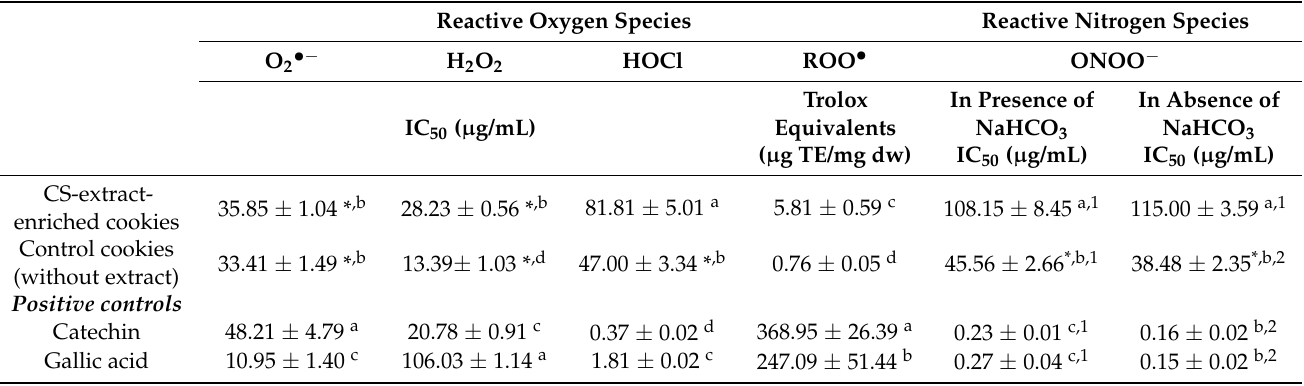
Table 4. Counteracting capacity of functional cookies enriched with chestnut shells extract and control cookies (without extract) against reactive oxygen and nitrogen species ( n =